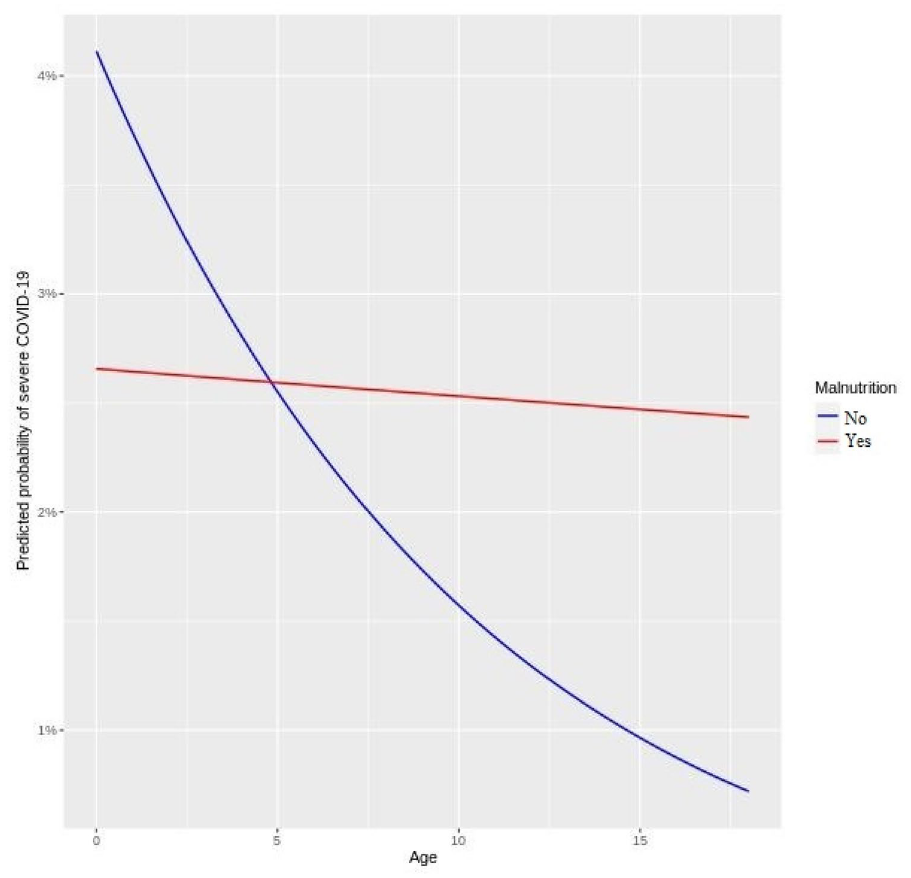
Figure 1. COVID-19 severity and interaction between malnutrition and age in